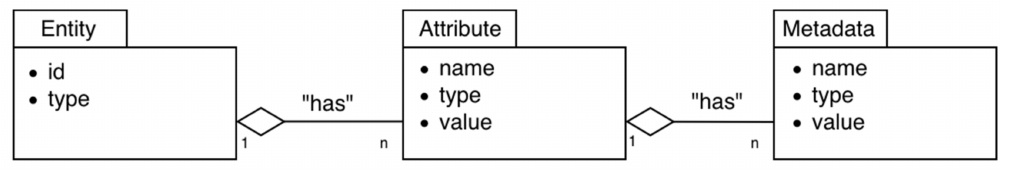
Figure 4. The OMA NGSI meta-model [55].